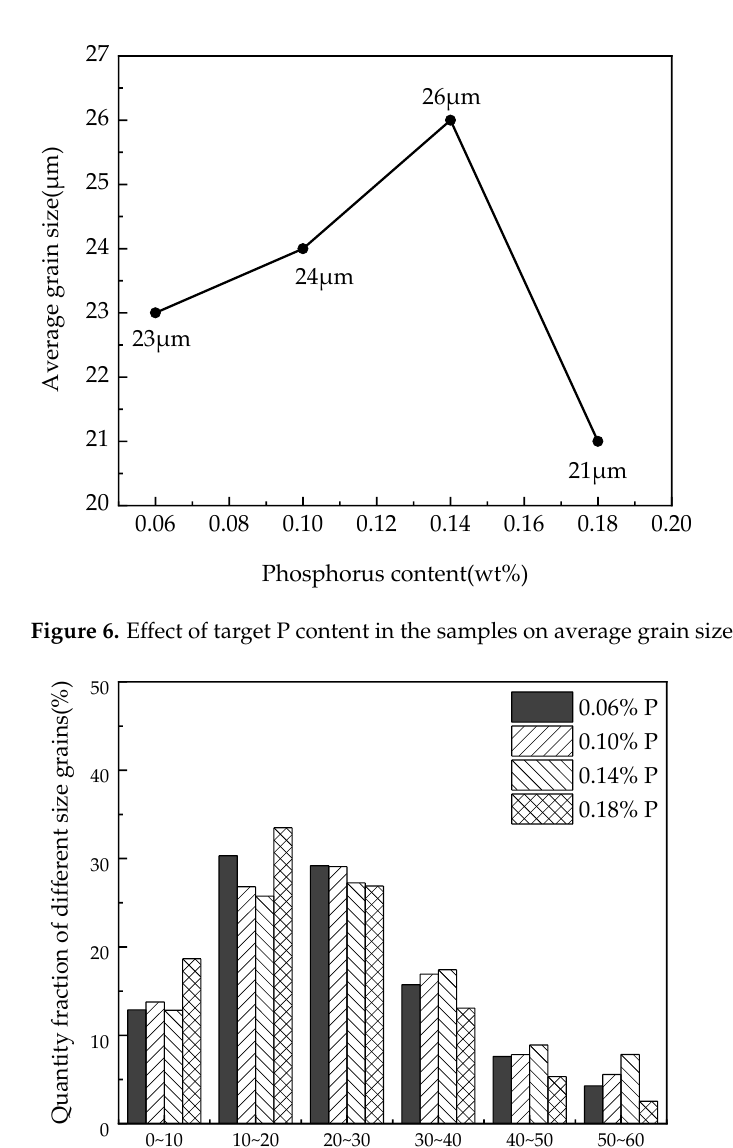
Figure 7. Quantity fraction of different size grains in the different P-targeted samples. It was found that the number density of the precipitates decreased and their average size increased after the target phosphorus content in the sample increased to 0.14%. As a result, the pinning force on the grain boundary weakened, which is conducive to grain growth, and the average grain size of the steel increased. A similar result was reported by Li [21]: the precipitation of 0.3~0.7 µ m-scale particles at the grain boundary hindered the growth of the grains. On the other hand, the fine precipitates in the samples reduced as a result of phosphorus segregation at the grain boundaries, and part precipitates coarsened, which weakened the pinning force at the grain boundaries or domain wall and increased the grain size, resulting in an improvement in the magnetic properties. To evaluate the effect of precipitates’ characteristics on the grain growth, the pinning force that prevents the grain from growth was approximately estimated by applying the pinning theory proposed by Zener and calculating Formulas (2)–(6) from [22–25]. The equations are as